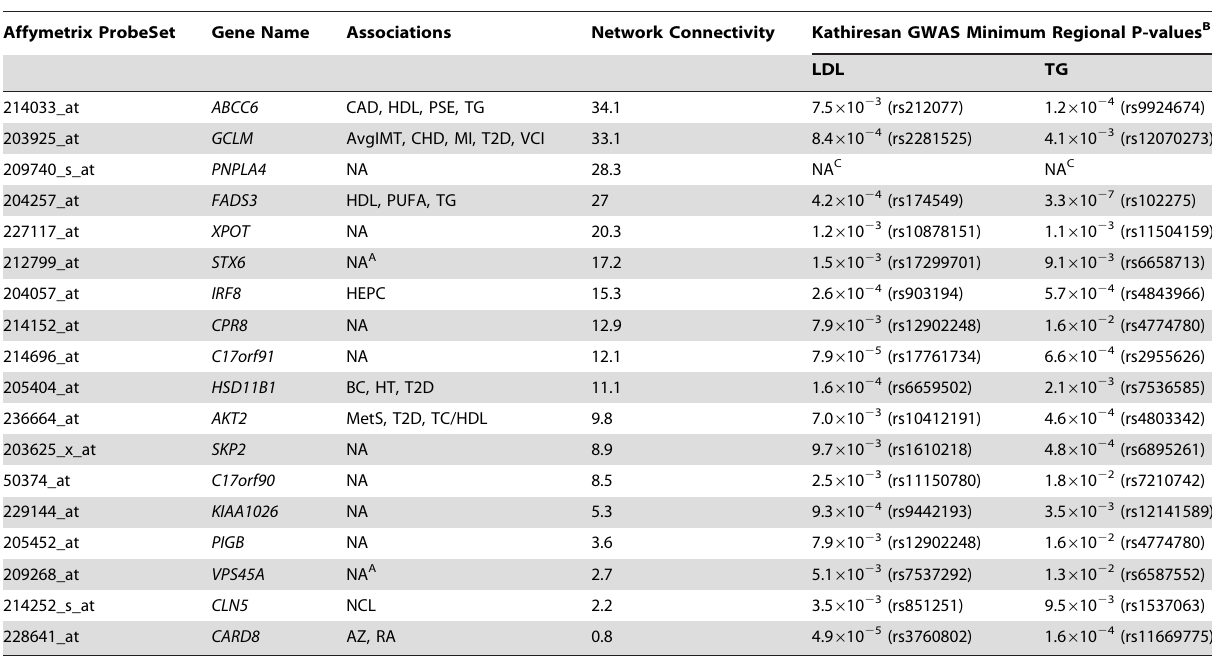
Table 4. Genes causally linked to FCHL (rs3737787 R Gene Expression R FCHL) with LEO.NB. SingleMarker score $ 0.30 from the URFA